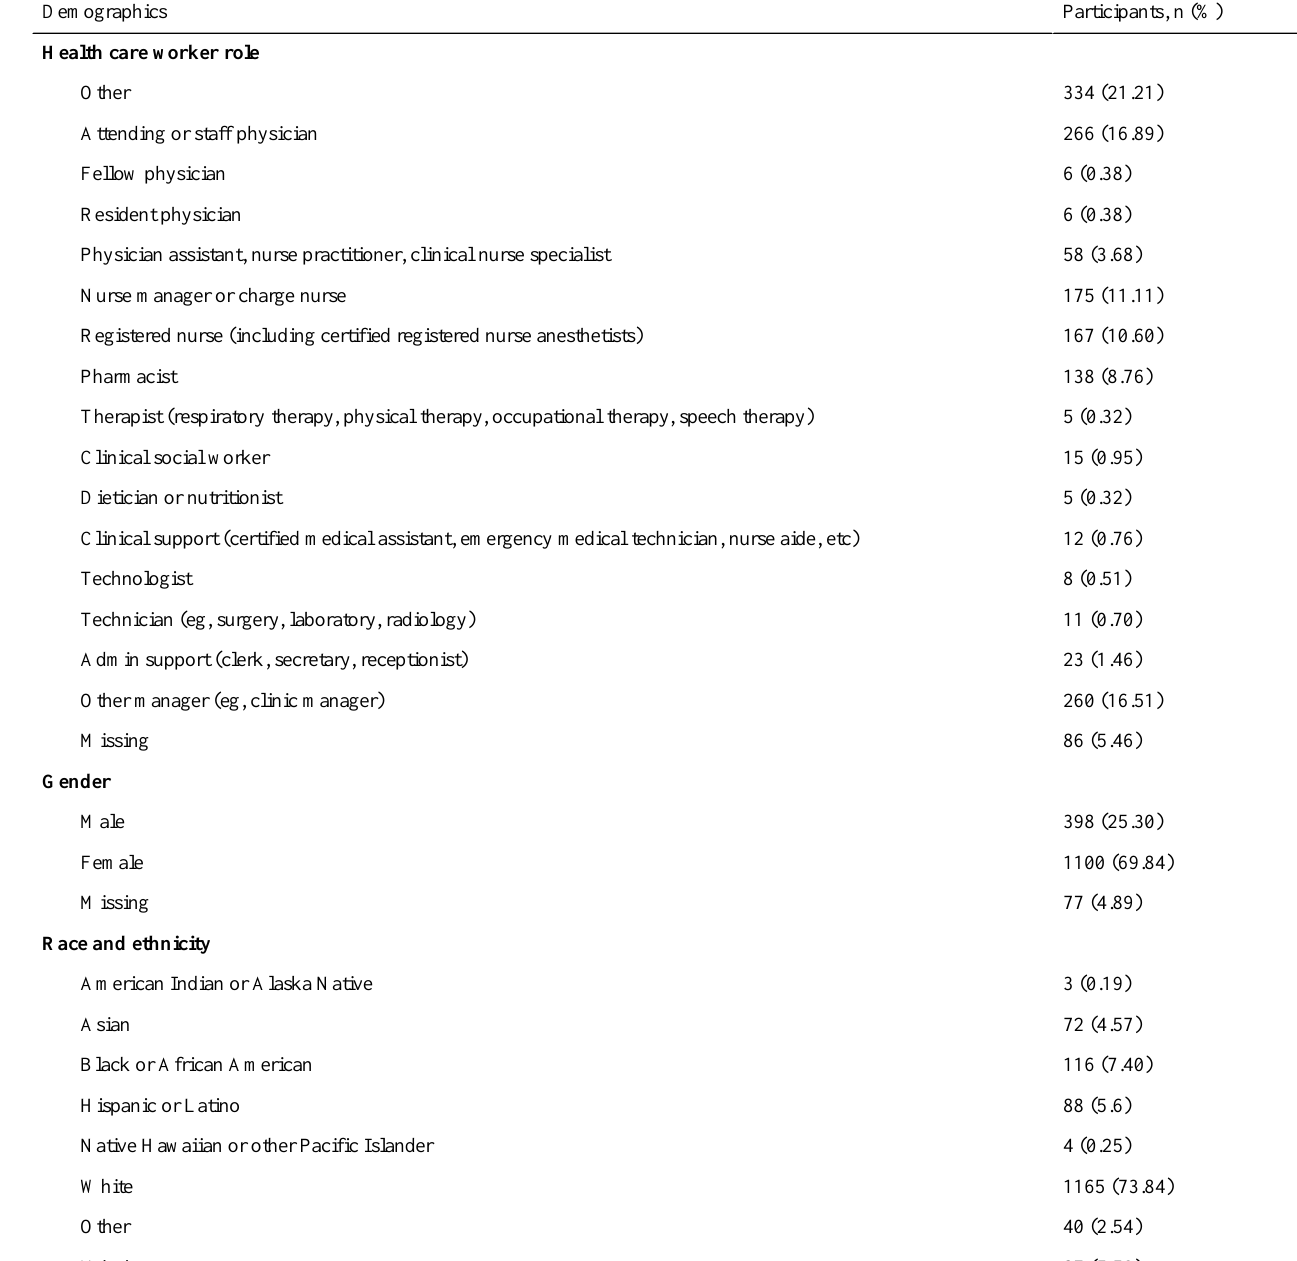
Table 1. Respondent demographics of gratitude letter–writing participants